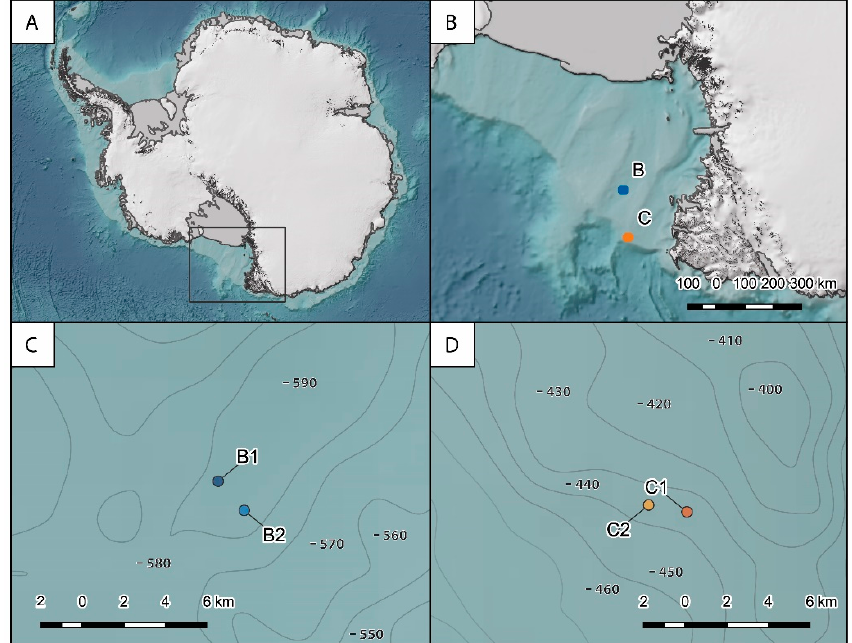
Figure 1. Location of the study area ( A ) and sampling locations of the two benthic deep-sea sites investigated ( B ) and of the stations within sites B ( C ) and C ( D ). The map was generated upon freely available layers within QGIS 3.22 environment (http://www.qgis.org; accessed on 7 January 2022).